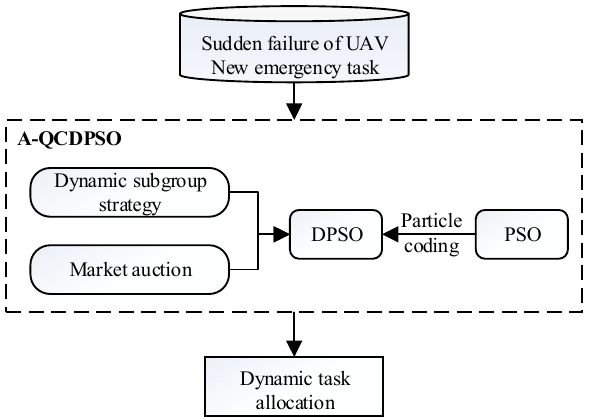
Figure 2. The structure of the A-QCDPSO algorithm.